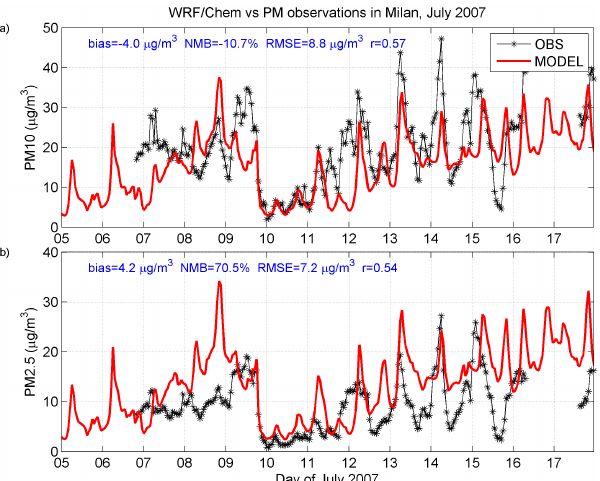
Figure 3. Same as Fig. 2 but for hourly gas-phase variables at ground level in Milan on 5–17 July 2007. Shown in the inset are statistical indices defined in Appendix A.